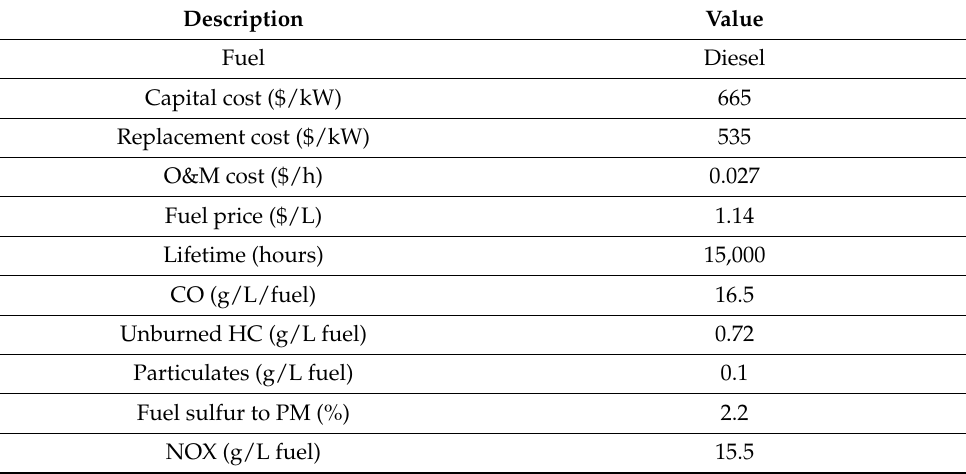
Table 4. Technical details of the diesel